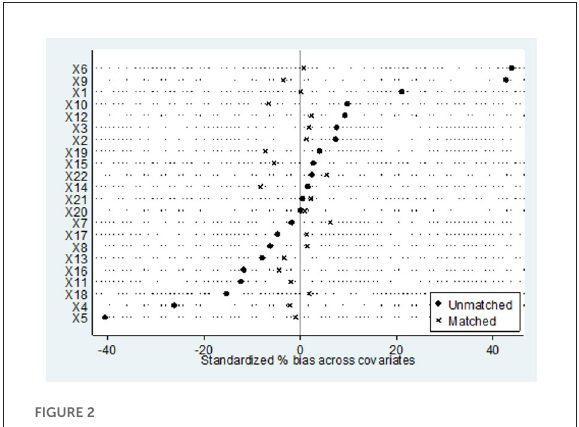
FIGURE2 Standardized deviation diagram of